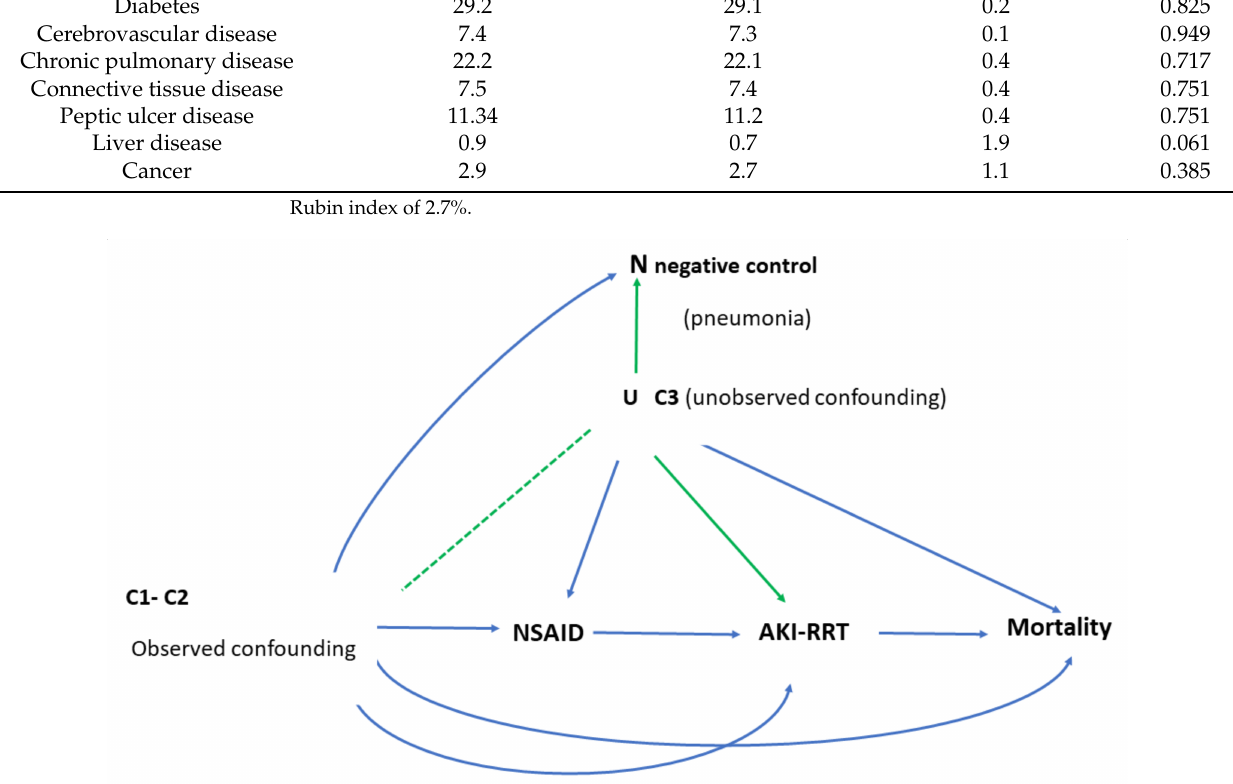
Figure 2. Causal pathway between NSAIDs and AKI and the relationship with confounding